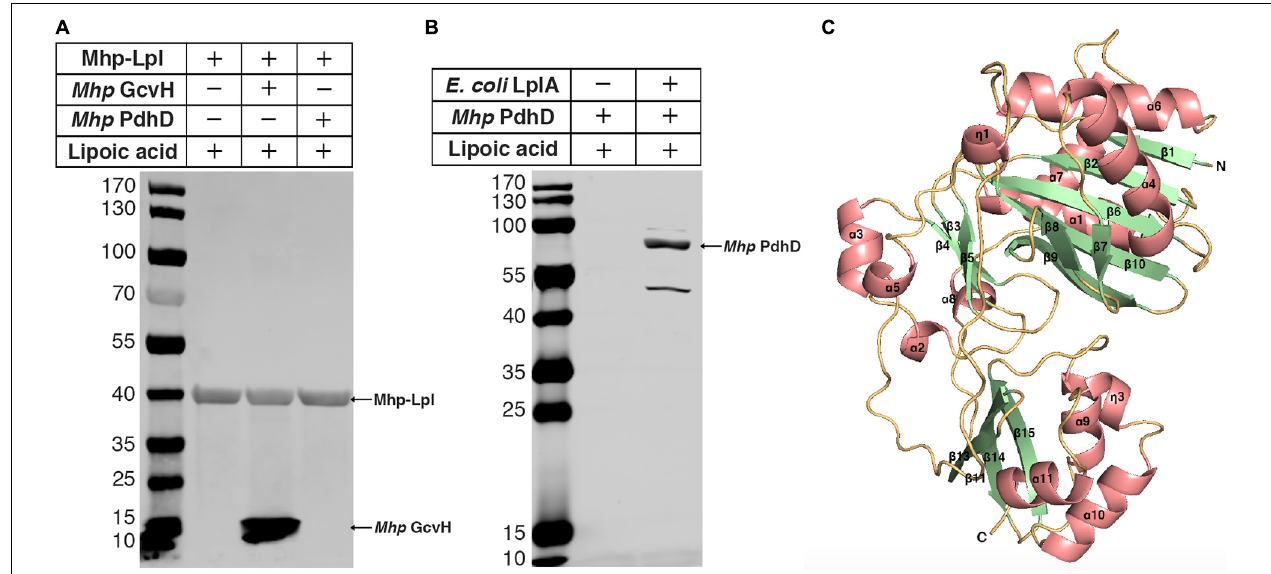
FIGURE 3 | Modification analysis of PdhD by Mhp-Lpl and structural modeling of Mhp-LplJ. (A) The lipoate ligase activity of Mhp-Lpl was tested using the lipoate ligation assay with GcvH ( Mhp GcvH) and PdhD ( Mhp PdhD) of M. hyopneumoniae as substrates. Following the reaction, the lipoate modification of the substrates was probed with Anti-LA using western blot assay. (B) The lipoate modification of PdhD was probed with Anti-LA after reaction with E. coli LplA using western blot assay. (C) The overall structure of apo-Mhp-LplJ. Salmon, α -helix; pale green, β -sheet; light orange, random coil. The 3D structure model of apo-Mhp-LplJ was predicted using the Swiss-Model server with Sp-Lpl (PDB: 1VQZ) as the template.